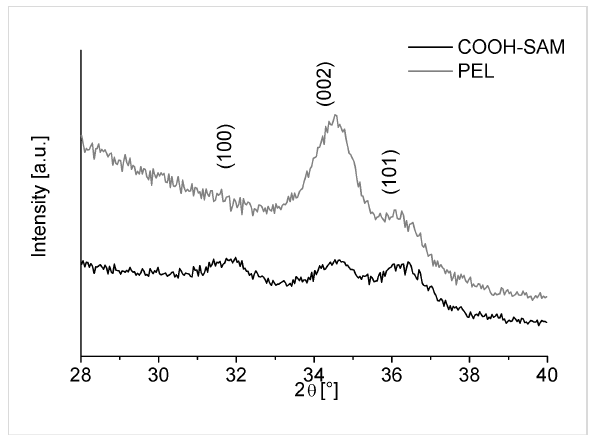
Figure 3: X-ray diffractograms of ZnO films deposited on carboxylate- SAM (black) and PEL (grey). The enhanced relative intensity of the (002)-peak of the PEL sample shows the preferred orientation of the